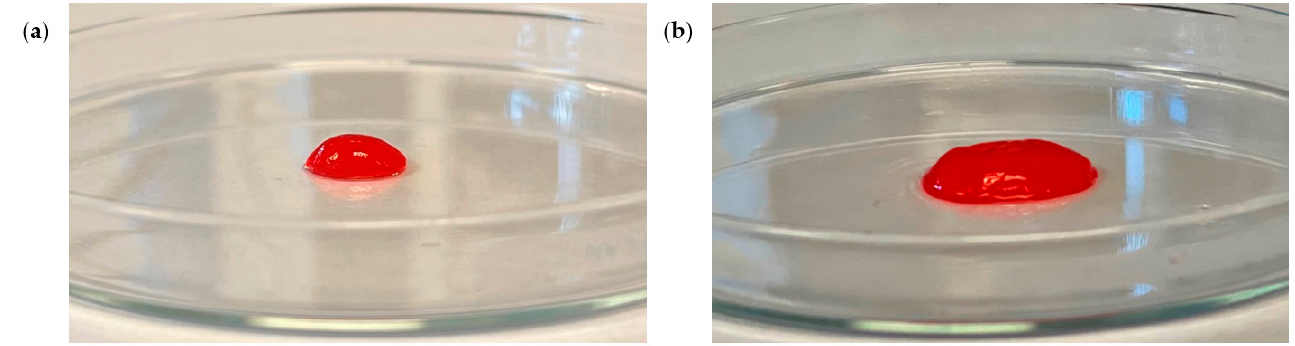
Figure 3. Bioprinted constructs of fibrin-based bioink with phenol red. ( a ) A dome-shaped (~10 mm in diameter) construct within a glass Petri dish. ( b ) A disc-shaped (~30 mm in diameter) construct within a glass Petri dish.